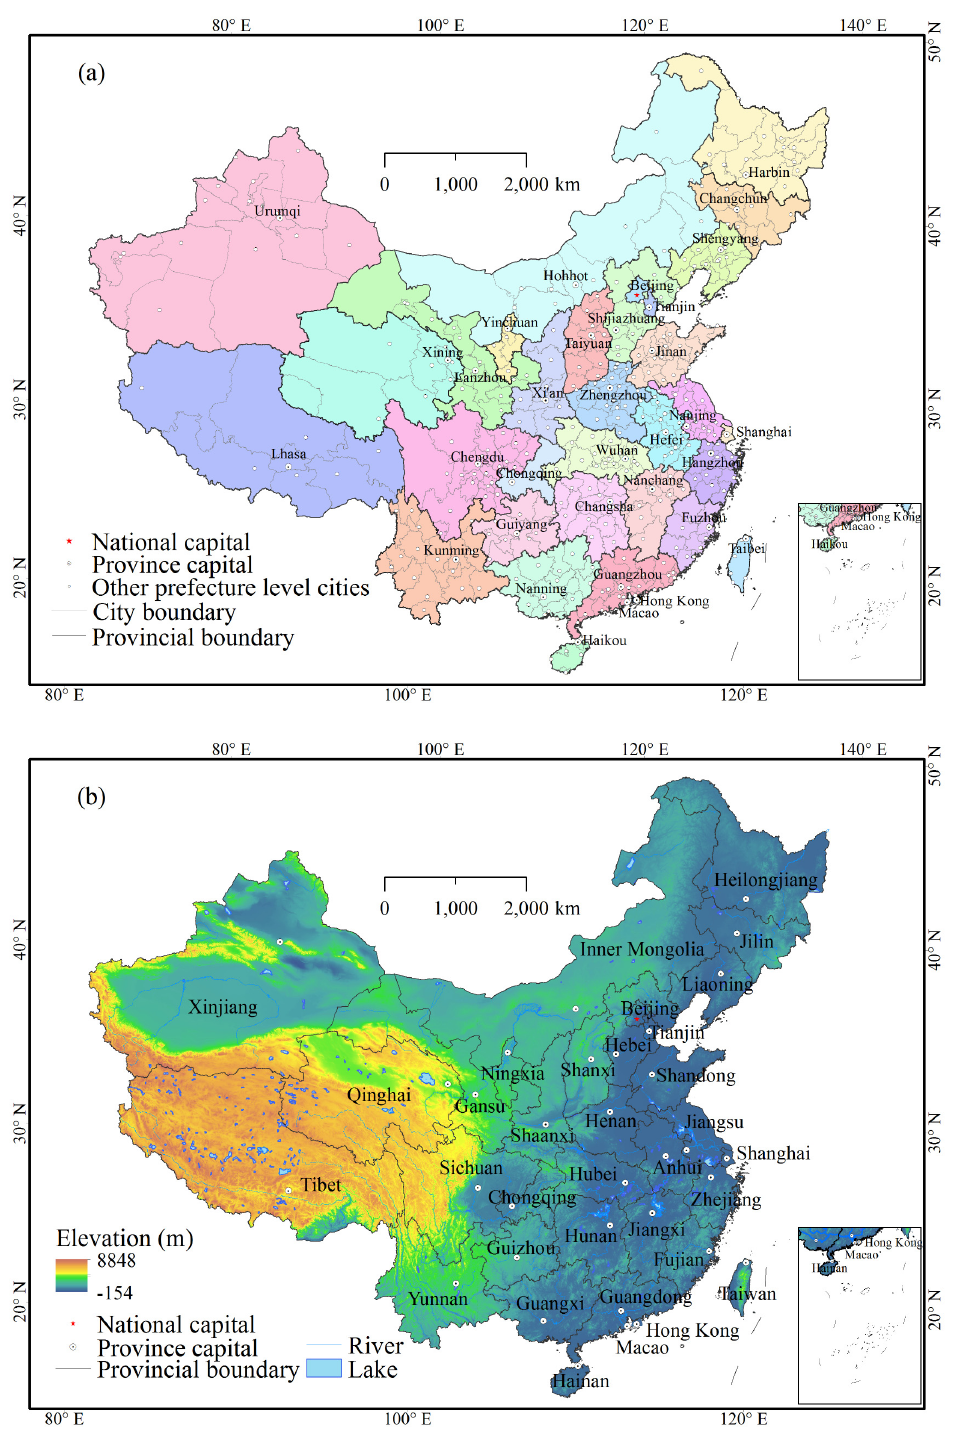
Figure 1. ( a ) Locations of major cities in China and ( b ) spatial distribution of elevation, rivers, and lakes.